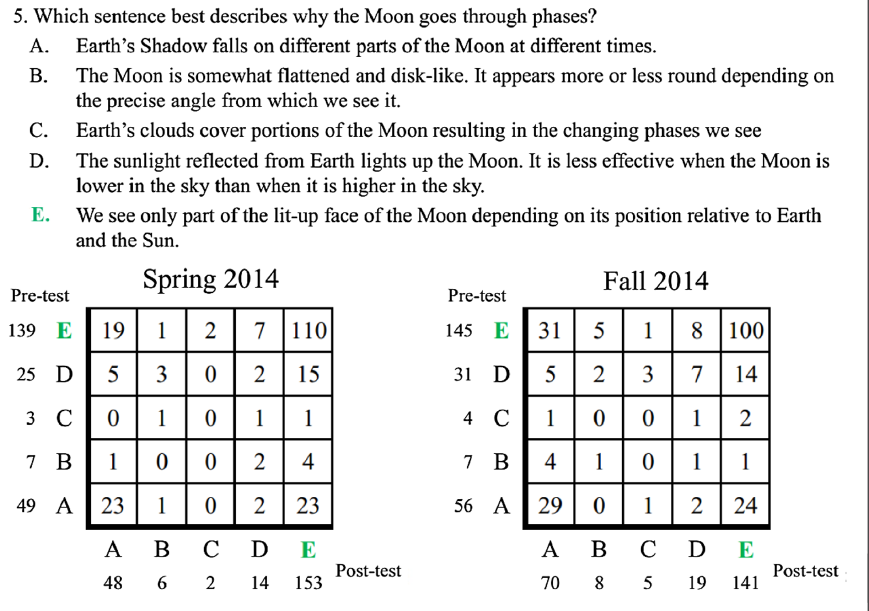
FIG. 5. Comparison of how students responded to TOAST question 5 on the pre- and post-test. Question adapted from Ref.